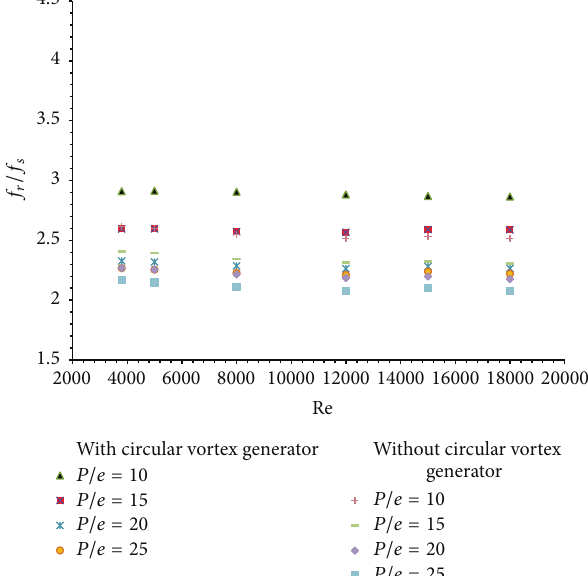
Figure 11: Variation of average friction factor enhancement ratio ( 𝑓 𝑟 / 𝑓 𝑠 ) with Reynolds Number